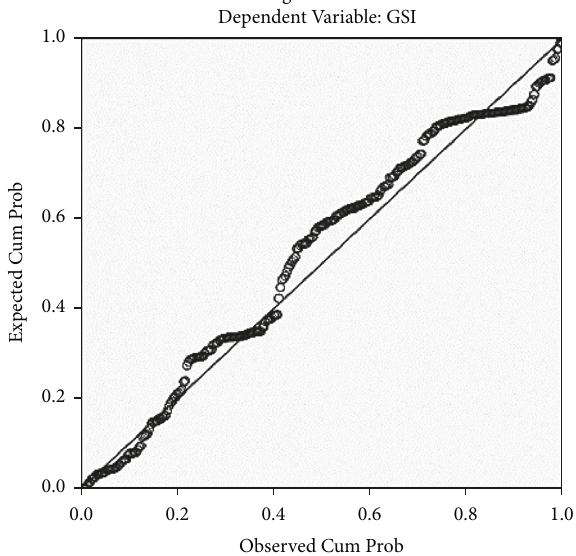
Figure 7: The normal P–P plot of regression standardized residual.